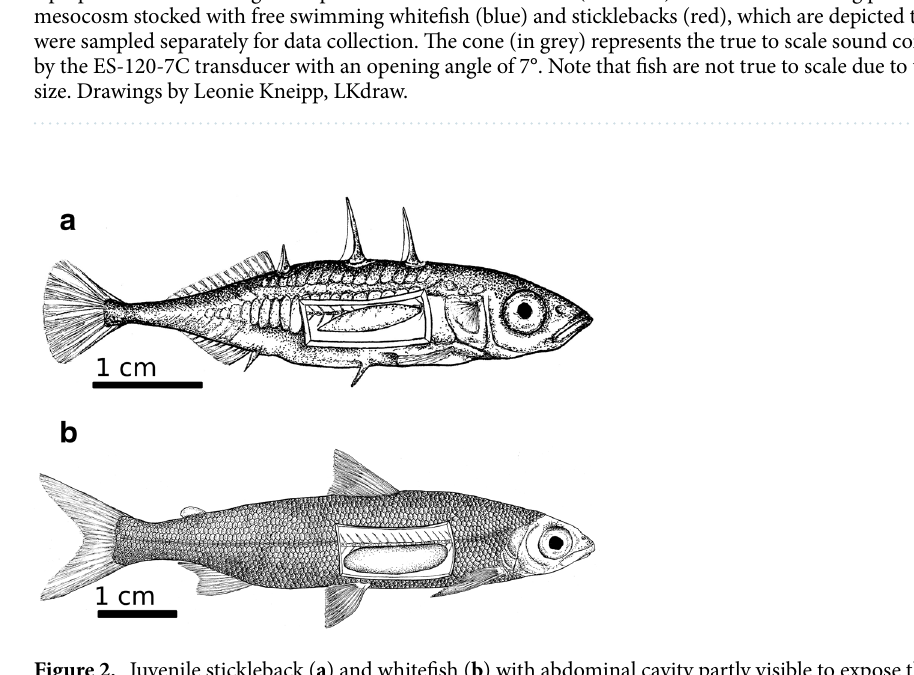
Experimental animals. Fish used for the experiments were 90 wild caught juvenile and adult sticklebacks measuring 5.1 cm ± 0.7 cm TL (mean ± SD), the most common size for the season, and 90 hatchery-reared juve- nile offspring of wild whitefish (7.0 cm ± 0.6 cm TL). Sticklebacks were obtained from a trawl net fishery in Lake Constance shortly before the experiment began and kept in 240 L flow-through basins supplied by lake water until the start of the experiment. Water temperature and oxygen concentration were measured twice daily and sticklebacks were fed once a day with chironomid larvae. The whitefish were hatchery-reared offspring of wild spawners obtained from the Fish Hatchery of the Stocking Commission in Langenargen, Germany. The fish were kept in the hatchery and fed with commercially available dry food until needed for the experiment. The two species differ in body covering and the shape of the swim bladder: sticklebacks have bony plates and a swim bladder with tapered ends while whitefish are fully scaled with a rounded swim bladder (Fig. 2). In both species the swim bladder length to body length ratio is similar, around 22% (± 2.5% SD) for stickleback and 24% (± 3% SD) for whitefish.